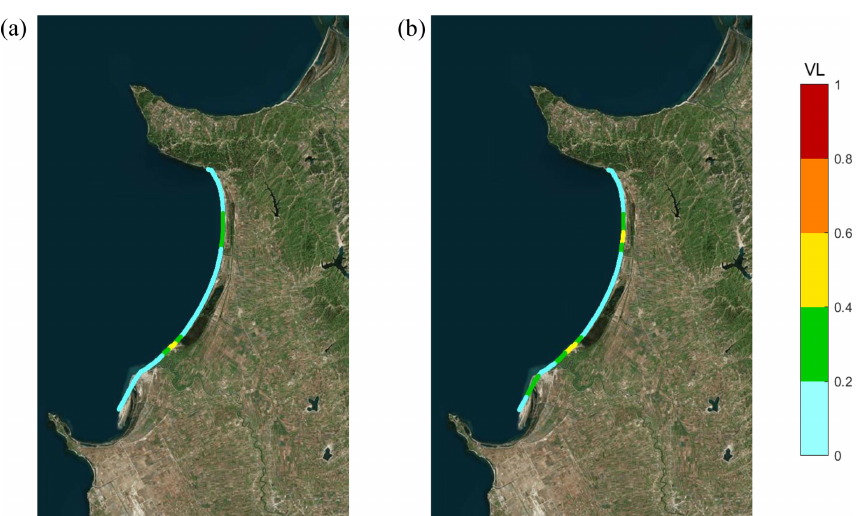
Figure 8. Run-up vulnerability levels for the Bay of Lalzit, using nearshore data for the 180–270 ◦ N sector: (a) 50-year return period; (b) 500-year return period.